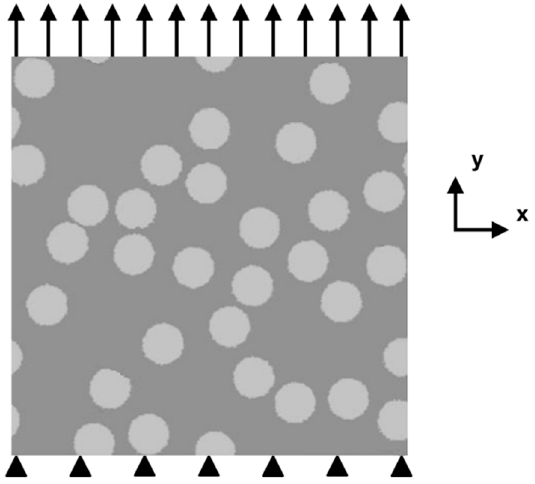
Figure 3. Uniaxial tensile test setup.